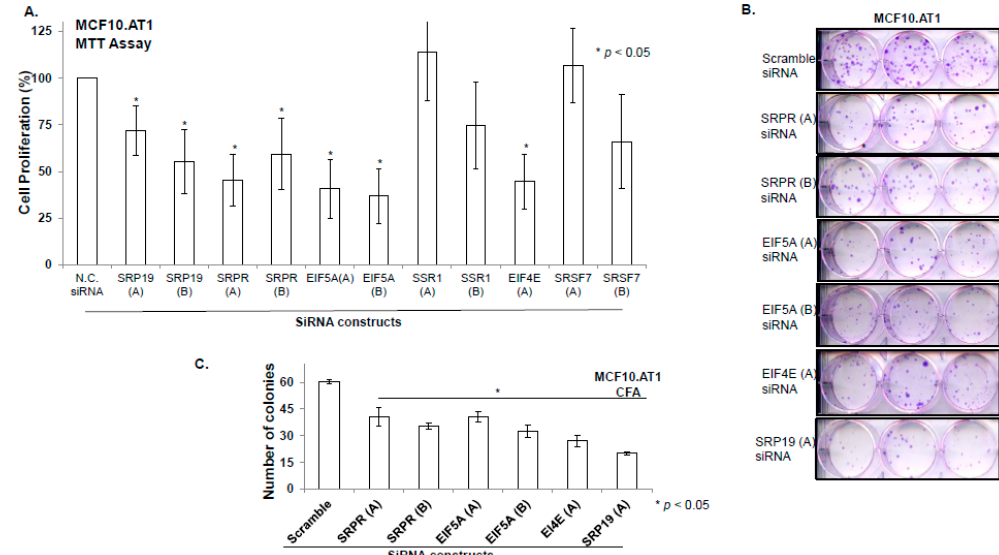
Figure 9. Depletion of key gene mediators of miRNAs driven target pathways / networks inhibits cellular proliferation and colonizing ability of preneoplastic MCF10.AT1 cells. ( A and B ) Bar diagram showing % cell proliferation ( A ) and quantification of colonizing ability ( B ) of MCF10.AT1 cells transfected with either scramble negative control siRNA or siRNA of the indicated genes. The graphs represent mean values + SEM. P values were calculated using students’ unpaired t test. * indicates p < 0.05. ( C ) Crystal violet stained colonies formed by MCF10.AT1 cells transfected with siRNAs of indicated genes or scramble negative control siRNA.